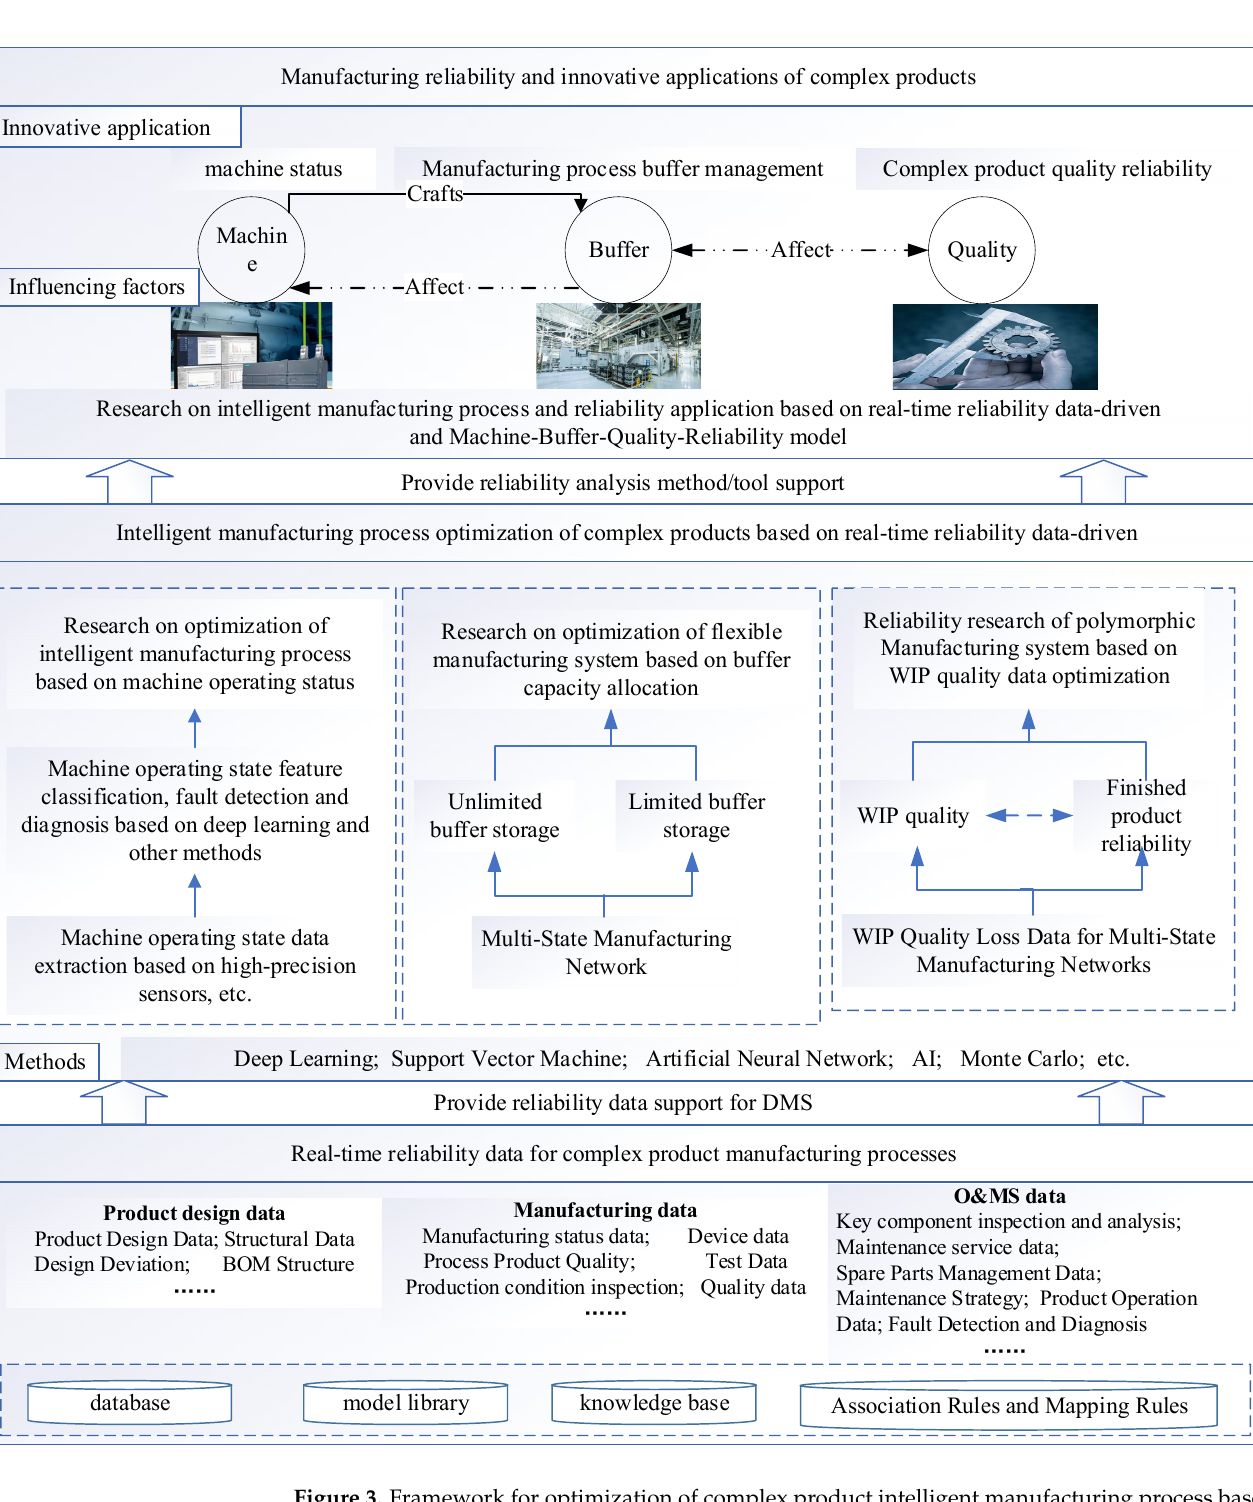
Figure 3. Framework for optimization of complex product intelligent manufacturing process based on real-time reliability data